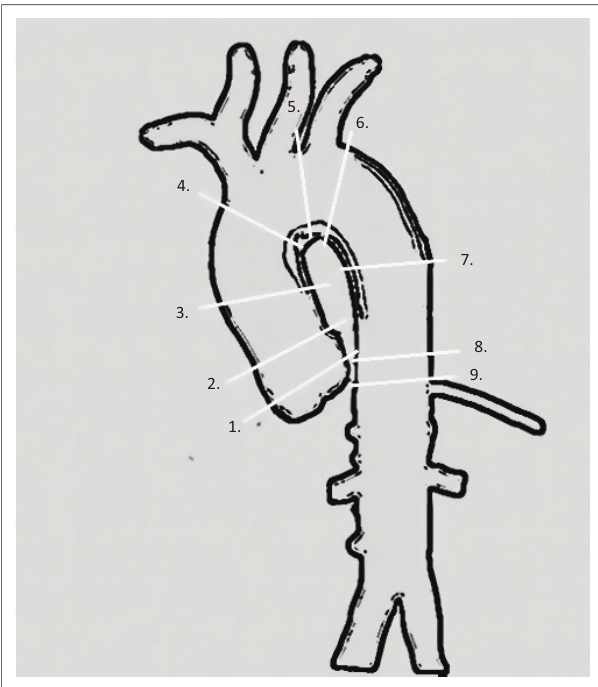
FIGURE 15: Line drawing of the standard aortic measurement positions: Sinus of Valsalva; (2) sinotubular junction; (3) mid ascending aorta; (4) distal ascending aorta (just proximal to the brachiocephalic artery); (5) mid aortic arch (between the left common carotid artery and left subclavian artery); (6) proximal descending artery (just distal to the left subclavian artery); (7) mid descending aorta; (8) distal ascending aorta (at the level of the diaphragm); (9) abdominal aorta (just above the coeliac